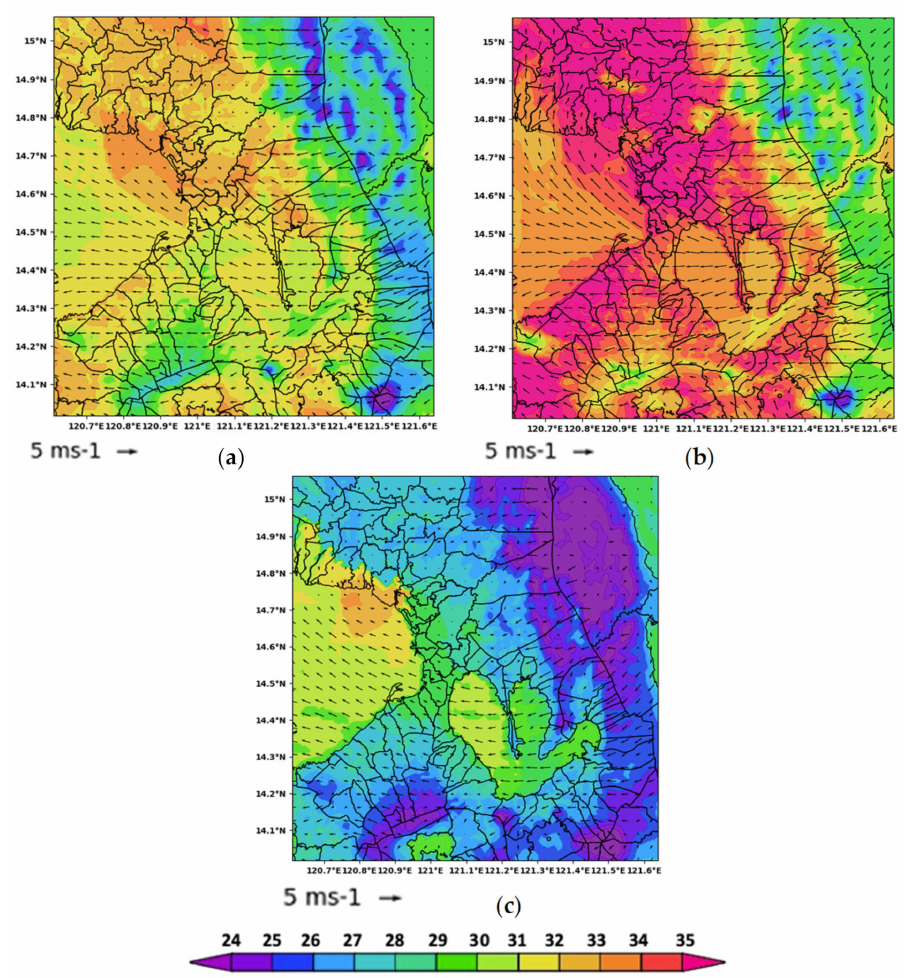
Figure 7. Evolution of air temperature ( ◦ C) and 10 m wind speed (m/s) simulated by BEM on 23 April 2018. ( a ) 9:00, ( b ) 14:00, and ( c )